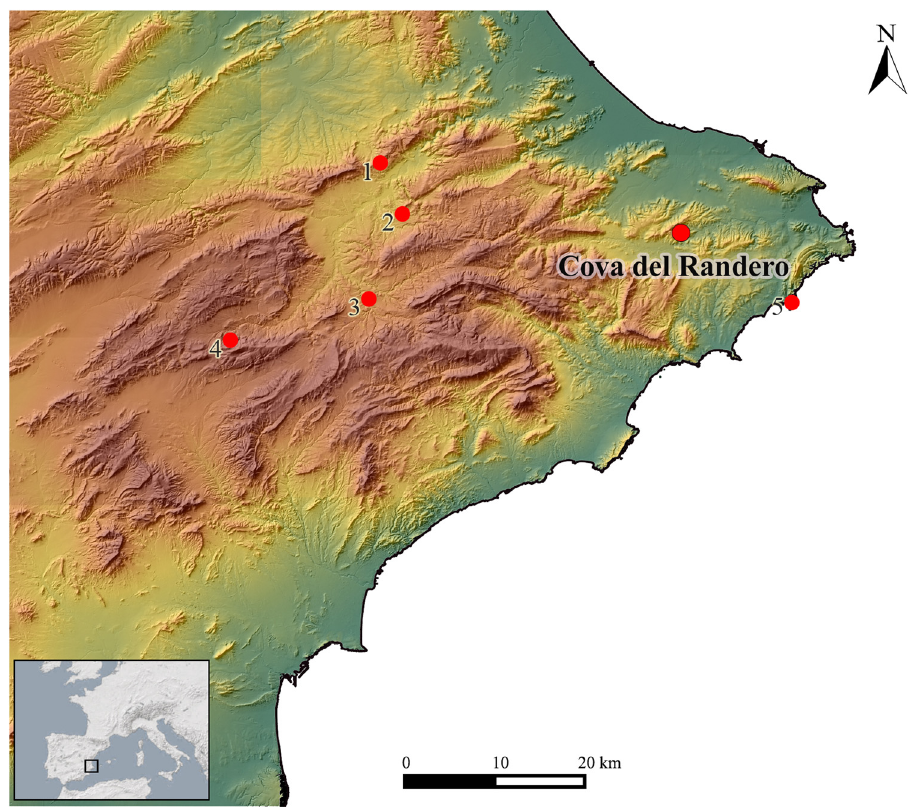
Figure 1: Location of the Cova del Randero. ( 1 ) Cova de l ’ Or, ( 2 ) Cova d ’ En Pardo, ( 3 ) Cova de la Sarsa, ( 4 ) Abric de la Falguera, and ( 5 ) Cova de les